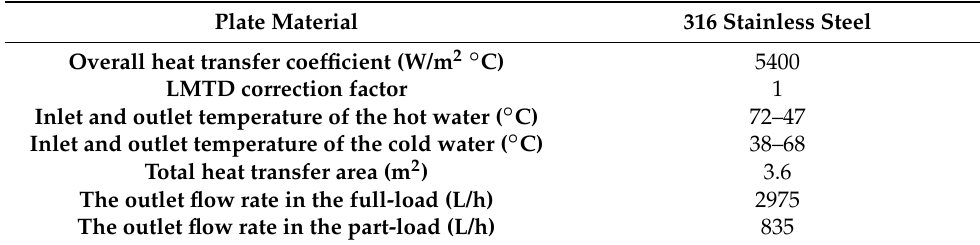
Table 10. Characteristics of the heat